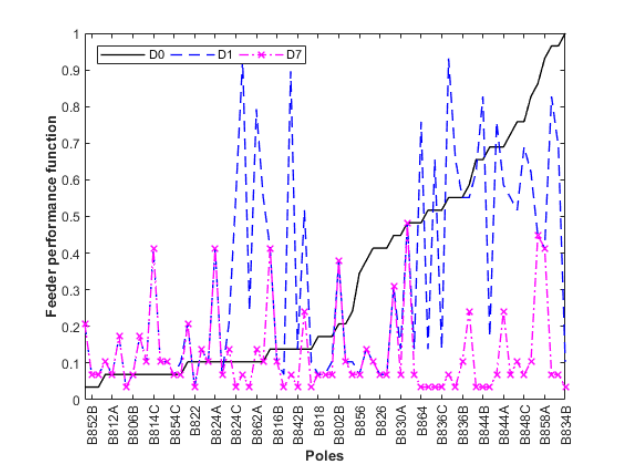
Figure 13. D function for the base case (D0), with lightning arresters installed at Pole 852 (D1) and at Poles 852 and 834 simultaneously (D2).